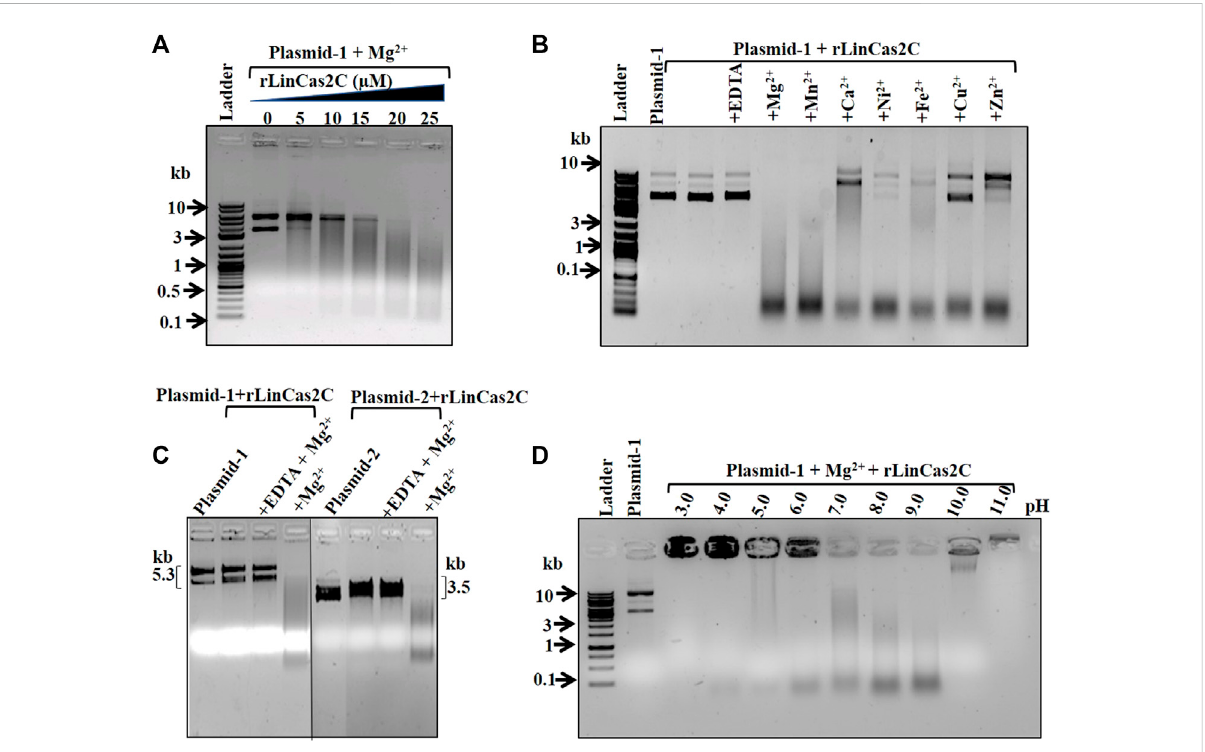
FIGURE 2 DNase activity of rLinCas2C on plasmid DNA. DNase activity reaction was carried out at 37 ° C for an hour. (A) Concentration-dependent DNase activity of recombinant rLinCas2C on plasmid-1 substrate (5.3 kb pET28a vector, 0.5 µg) in the presence of Mg 2+ ion. Complete cleavage of the substrate was observed using rLinCas2C at 25 µM. (B) DNase activity of rLinCas2C in the presence of different divalent metal ions on plasmid exempli fi es its optimum activity in Mg 2+ and Mn 2+ ions. (C) The substrate speci fi city of rLinCas2C on two different plasmid substrates. Substrate plasmid-1 and plasmid-2 (3.5 kb pTZ57 R/T vector, 0.5 µg) were employed for DNase activity. (D) DNase activity of rLinCas2C at different pH. The optimum activity was observed at pH 8.0 and 9.0. DNA ladder: 2 log DNA ladder (NEB). rLinCas2C: 25 μ M, EDTA: 2.5 mM, Mg 2+ and others divalent metal: 2.5 mM. Reaction products were analyzed on 2% agarose